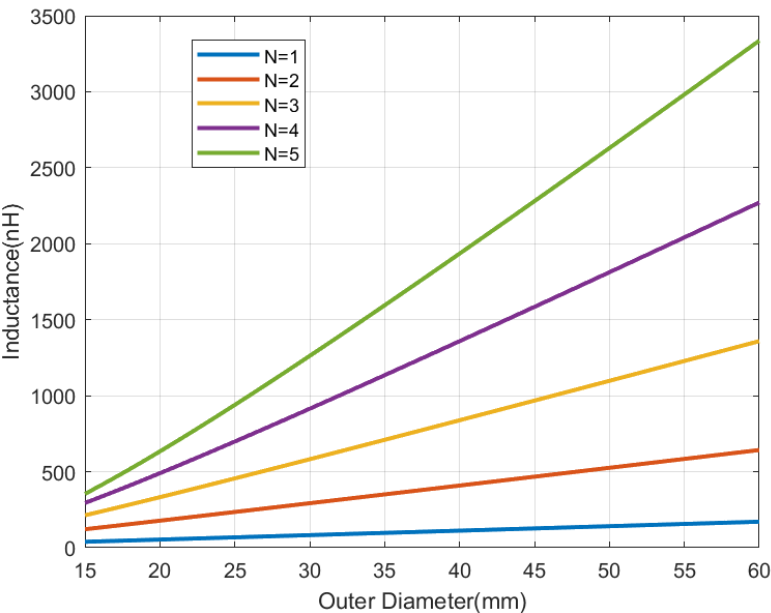
Figure 6. Simulated inductance as a function of the outer diameter for a square antenna with a different number of